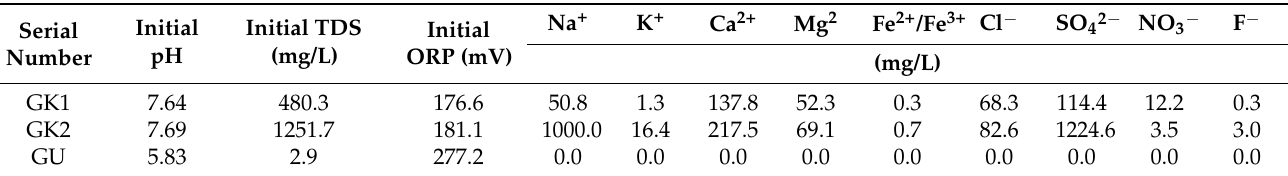
Table 1. Initial Water Quality Parameters and Hydrochemical Composition of the Coal Gangue Immersion Tests under Different Immersion